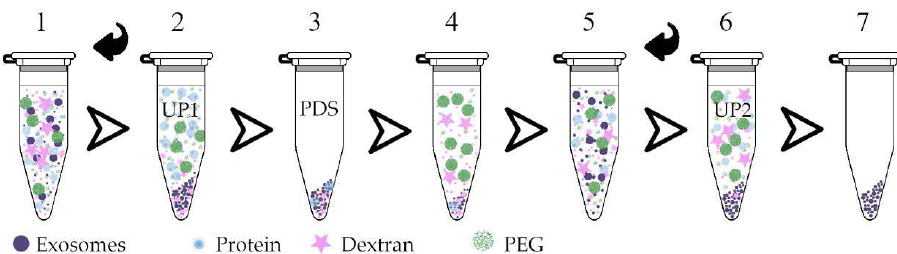
Figure 2. Steps of the PTPS-based extracellular nanovesicles (ENV) isolation protocol. ( 1 ) A mixture of plasma and polymers (dextran/polyethylene glycol); ( 2 ) two phases formed after mixing and centrifugation; ( 3 ) the upper phase “UP1”, containing PEG and proteins, is removed; ( 4 ) UP1 is replaced with a protein-depleting solution (PDS); ( 5 ) stirring; ( 6 ) the solution is again separated into two phases by centrifugation; ( 7 ) as a result, together with the formed upper phase “UP2”, protein residues are removed, while the lower phase contains dextran and ENVs.